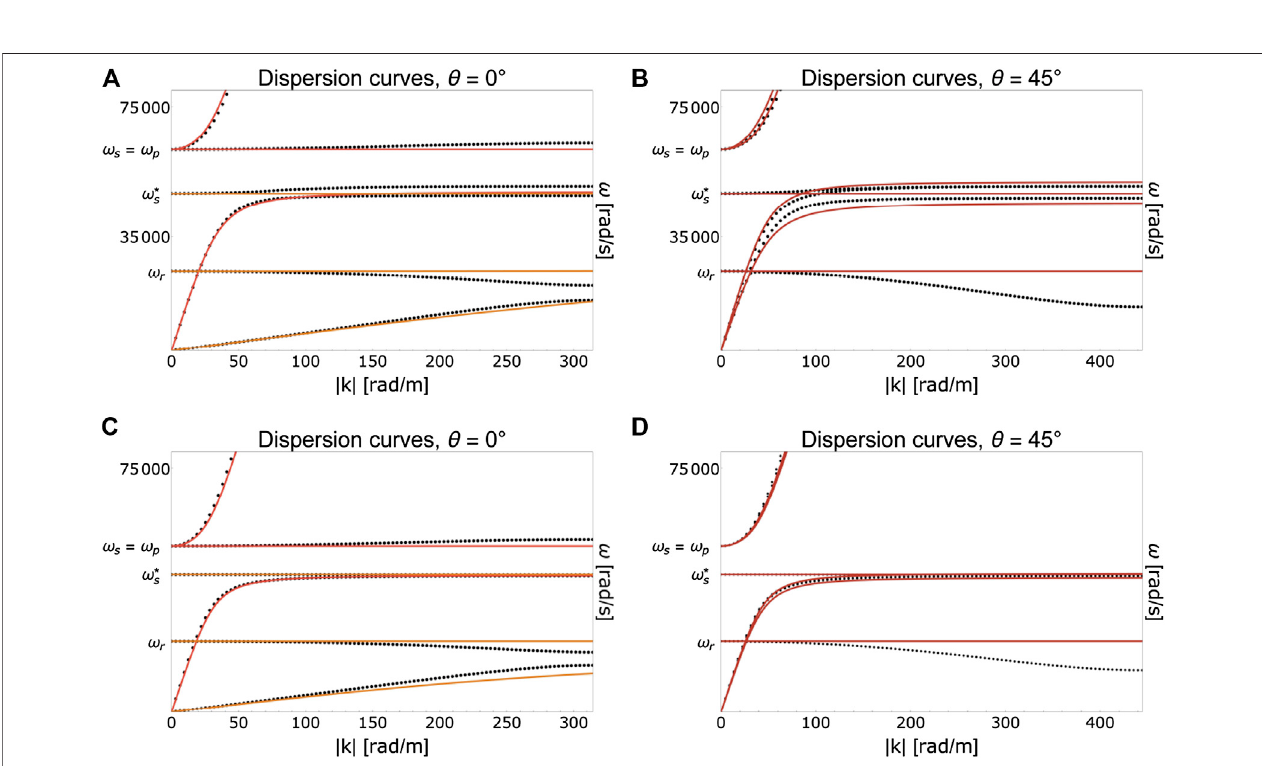
FIGURE 4 | Dispersion curves for the metamaterial MM2 (A, B) and MM3 (C, D) corresponding to two direction of propagation (A, C) θ (cid:2) 0 + and (B , D) θ (cid:2) 45 + .